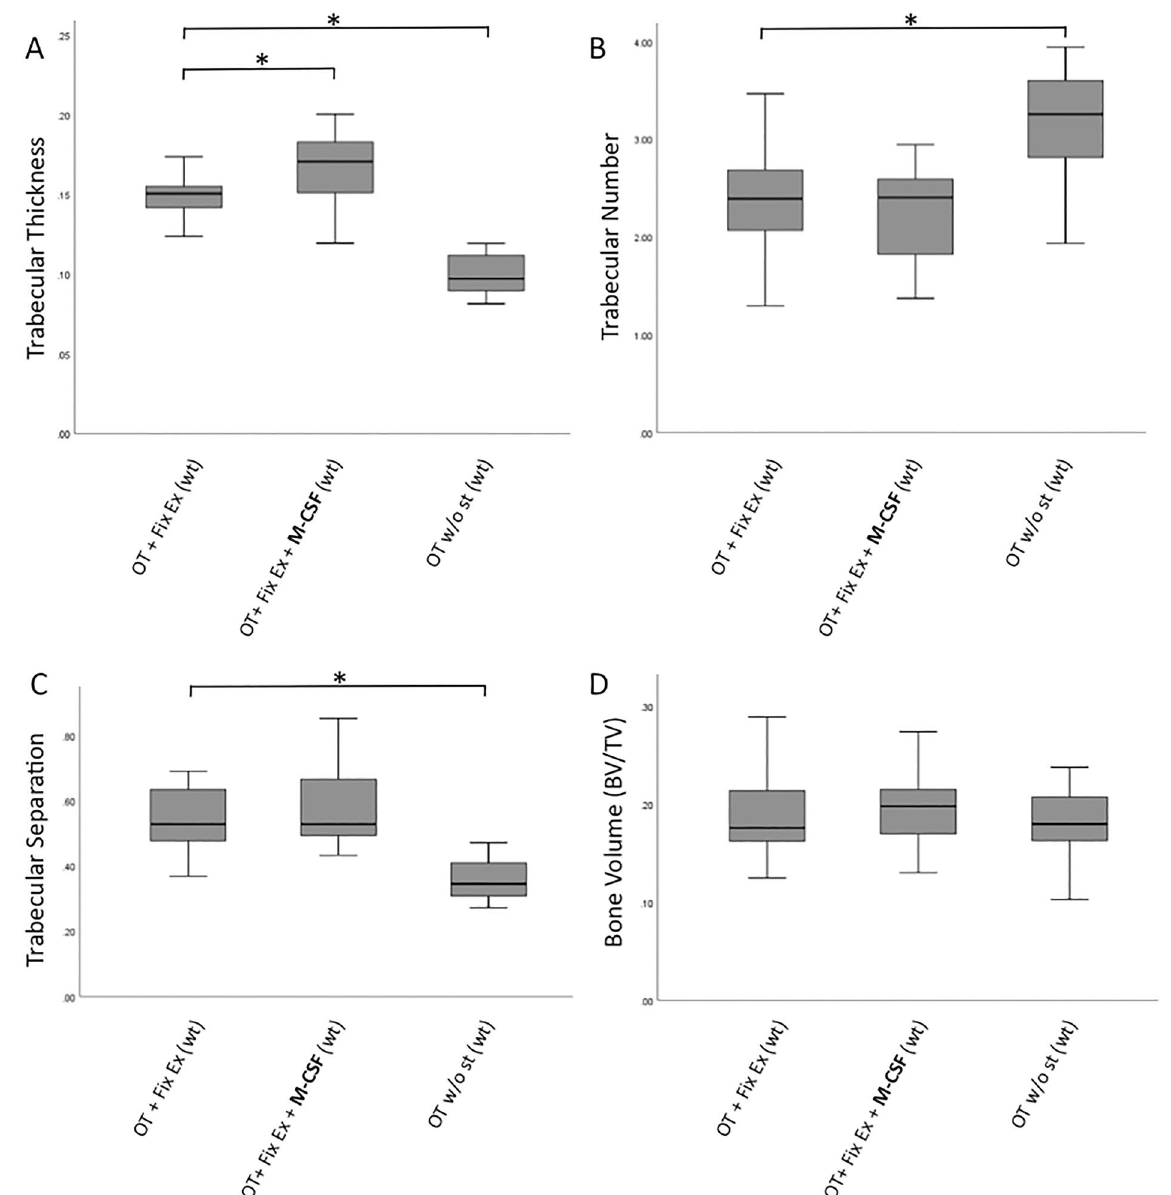
Figure 4. ( A – D ) Outcomes for trabecular bone microarchitecture (μCT): M-CSF treatment had a significant impact on fracture healing in mice treated with external fixator with respect to trabecular thickness (median trabecular thickness group 3: 0.0970, IQR: 0.0895–0.1120 vs. 0.1506, IQR: 0.1404–0.1587, P < 0.001). Interestingly, overall bone volume in terms of BV/TV was comparable between groups. M-CSF